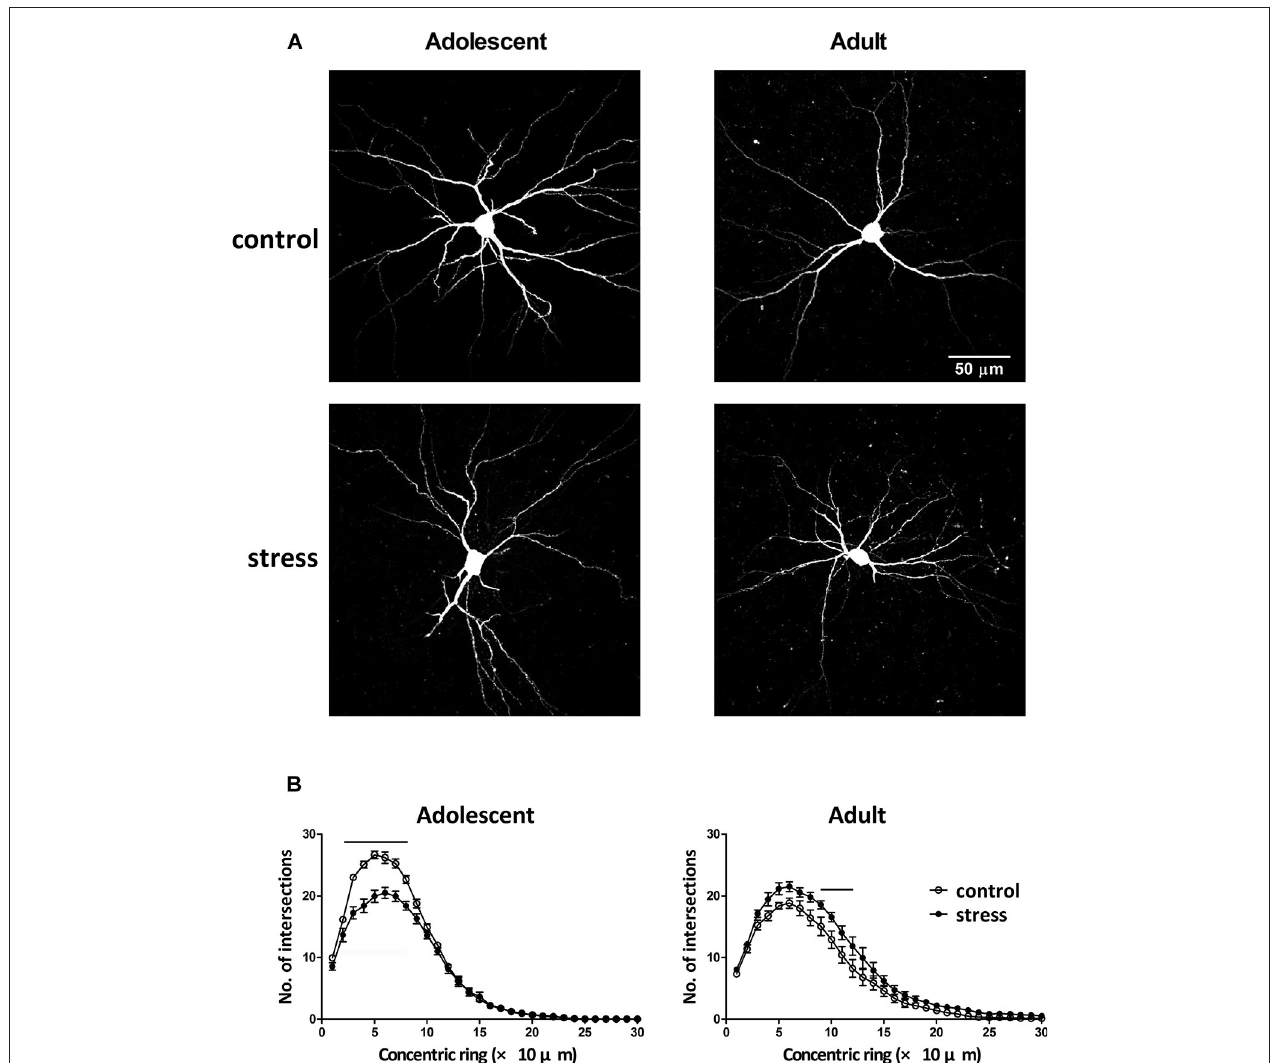
treatment. (B) Morphometric results were presented by the Sholl diagram. Bars indicate significant differences between stress and control groups in number of intersections with the concentric rings, repeated measured ANOVAs followed by Bonferroni’s post hoc